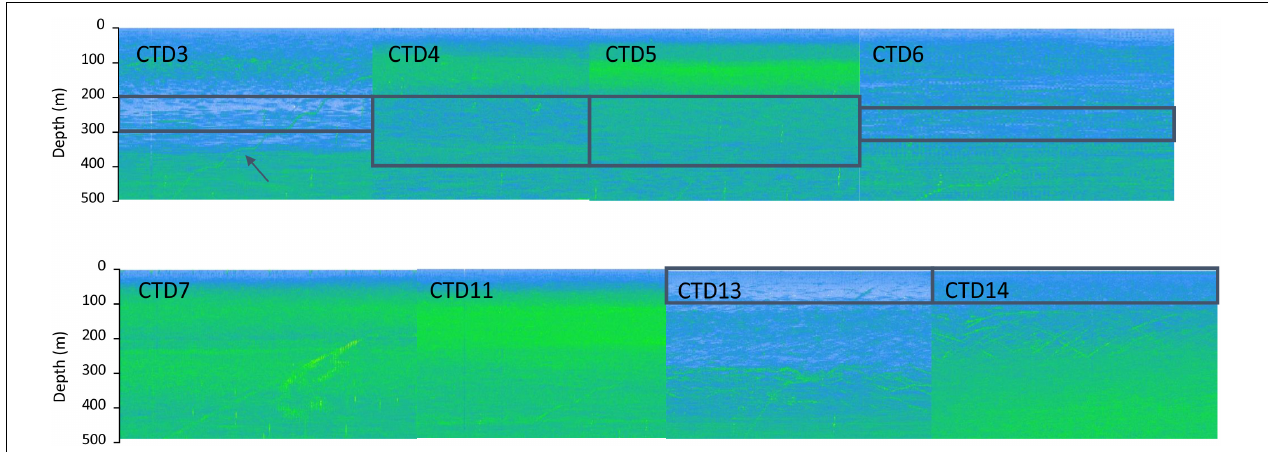
FIGURE 14 | Hydroacoustic data recorded during the upcast of the CTD-hydrocasts (arrow indicates CTD-upcast). Solely the upper 500 m of the hydroacoustic data are shown together with boxes that represent depths of peak methane concentrations. During hydrocasts CTD-7 and CTD-11, methane concentrations did not show a distinct plume and were below 5 nM, thus only slightly elevated compared to methane concentrations in atmospheric equilibrium. Increased methane concentrations were only observed in low backscatter